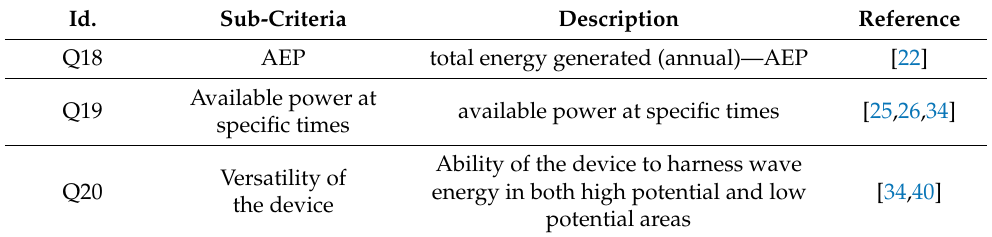
Table A5. Block 4: Influence of power generation capacity. Q18 to Q20.